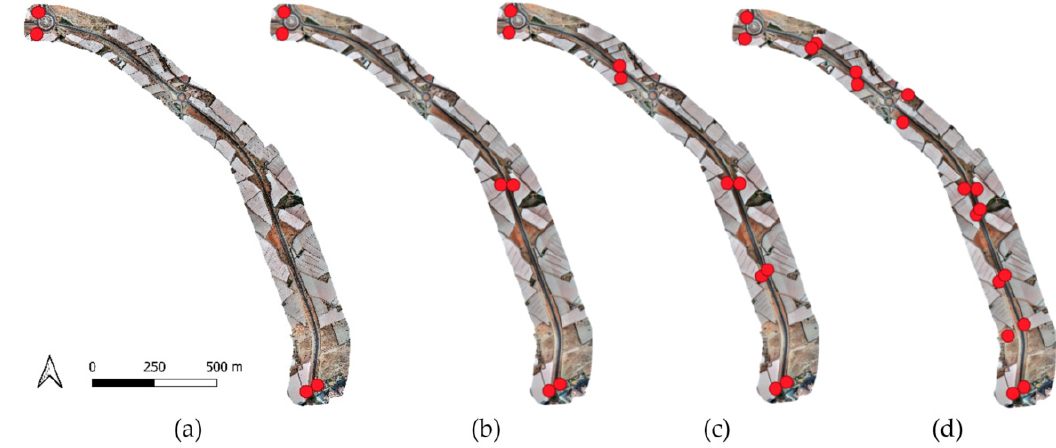
Figure 5. LocationofthetargetsusedasGCPs(reddots)foreachprojectwithinDistribution1. Fourprojects Figure 5. Location of the targets used as GCPs (red dots) for each project within Distribution 1. Four using ( a ) 4, ( b ) 6, ( c ) 10, and ( d ) 18 GCPs were carried out. projects using ( a ) 4, ( b ) 6, ( c ) 10, and ( d ) 18 GCPs were carried out.